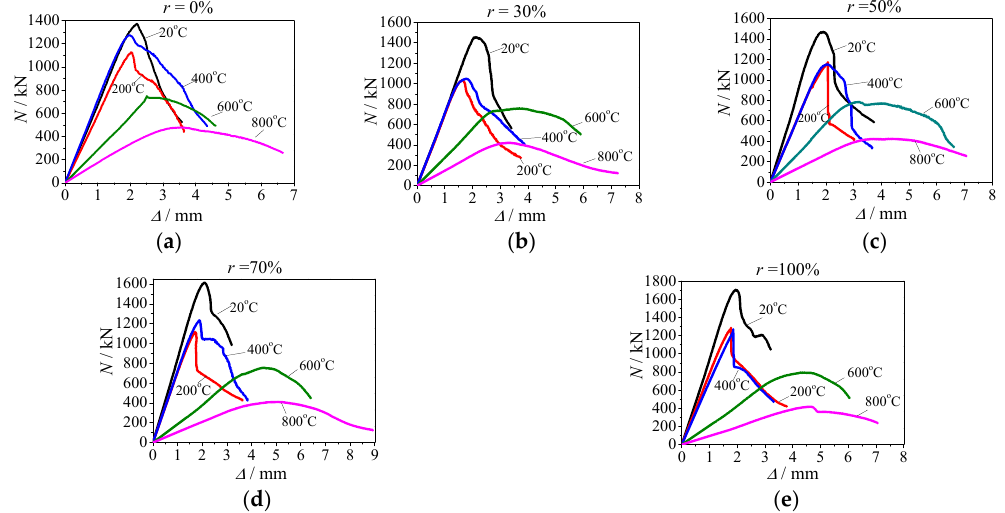
Figure 10. Load-displacement curves of RRAC columns. ( a ) r = 0%; ( b ) r = 30%; ( c ) r = 50%; ( d ) r = 70%; ( e ) r = 100%.